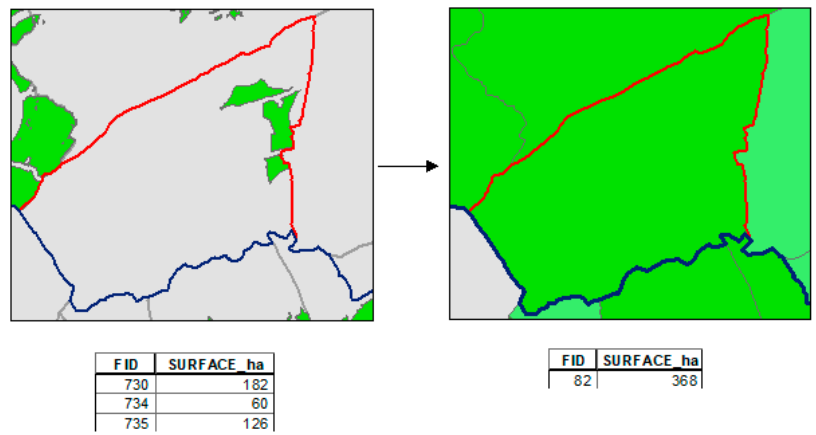
Figure 4. Example of change of observation unit from STEP 2 to STEP 3.